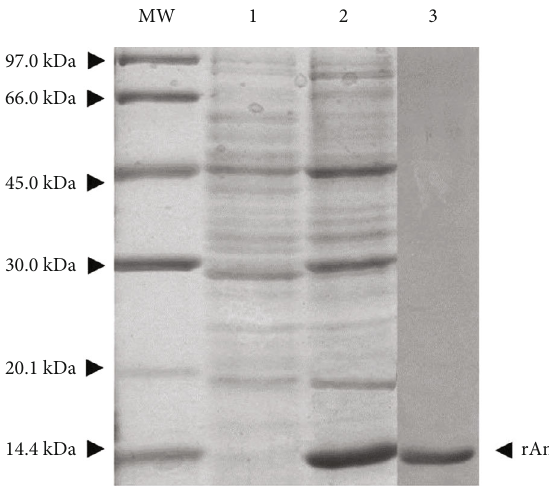
Figure 7: SDS-PAGE analysis of rAma r 2, after expression, after induction, and after puri fi cation. Notes: MW: molecular mass markers; 1: E.coli precipitate lysed without IPTG induction; 2: E. coli lysis precipitated after induction by IPTG; and 3: Ni-puri fi ed rAma r